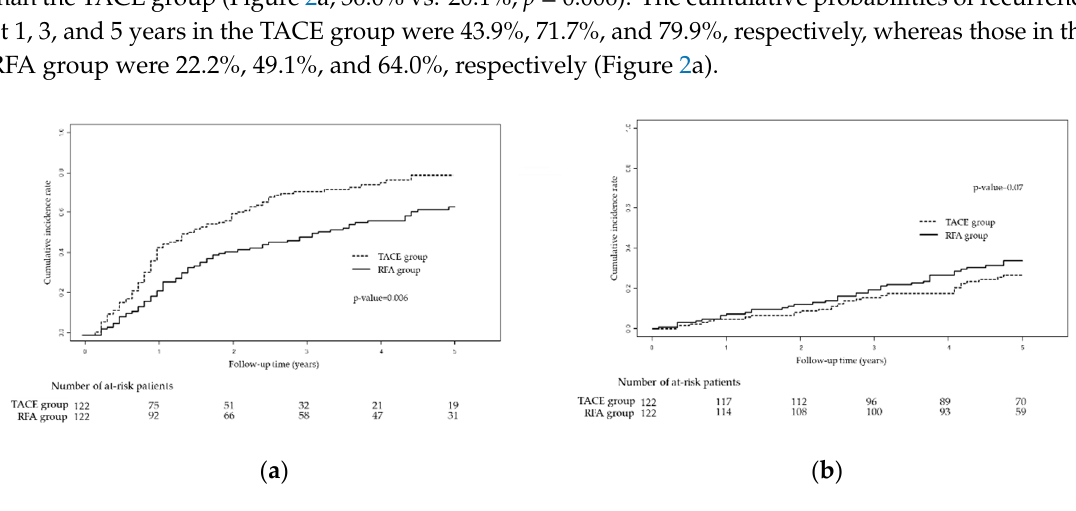
Figure 2. Kaplan-Meier curves showing ( a ) recurrence-free survival and ( b ) overall survival in the TACE vs. RFA groups after adjustment through propensity score-matching. Abbreviations: TACE, trans-arterial chemoembolization; RFA, radiofrequency ablation